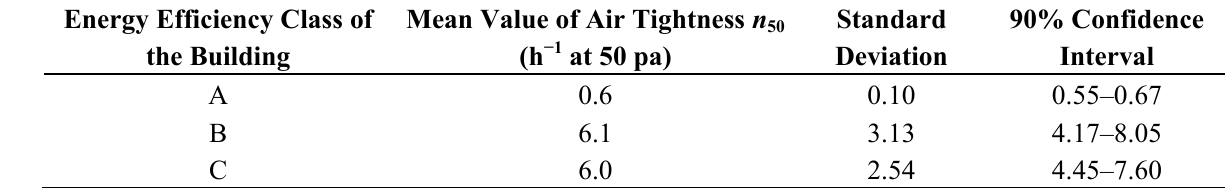
Table 3. Statistical data of air tightness of the tested